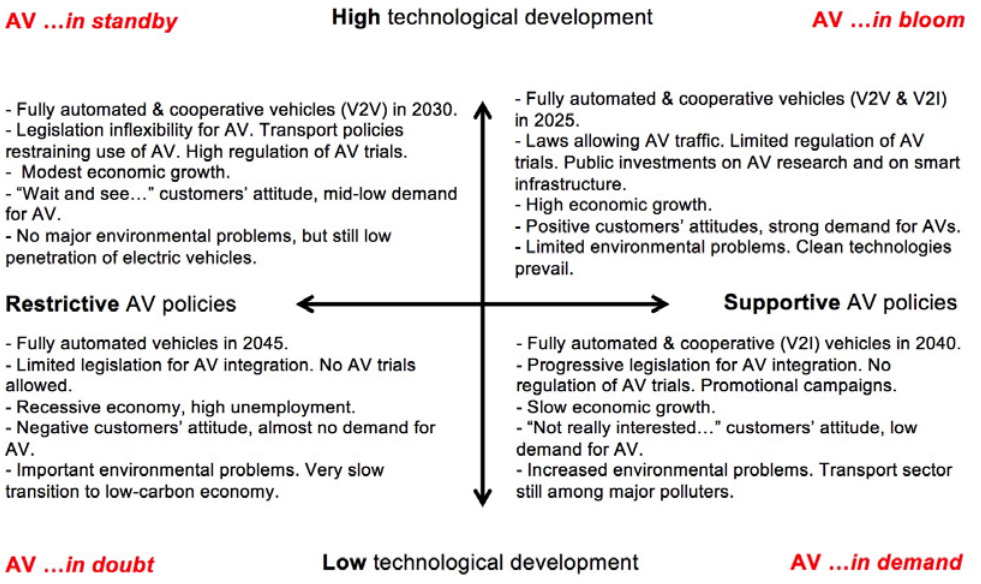
Figure 2. Scenario matrix about development of automated vehicles in the